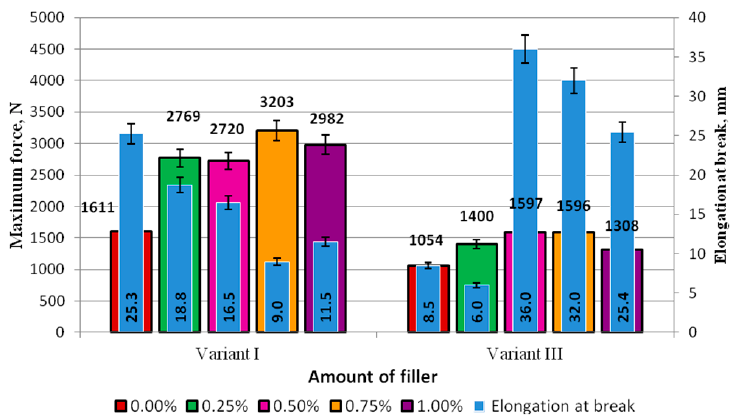
Figure 8. Comparison of the maximum force and elongation in the adhesive specimens prepared according to Method I and subjected to seasoning for 7 days (Variant I) and two months (Variant III). The elongation at break of the adhesive specimens modified with 0.50% of the modifier was higher by 0.56% than that of the same adhesive that was not subjected to seasoning. An even more significant difference, i.e., 72%, was observed regarding the elongation of the adhesive with 0.75% of the modifier. The elongation of the adhesive with 1.00% of the modifier after seasoning was higher by 55% than that of the modified adhesive with the same modifier content and cured for 7 days.